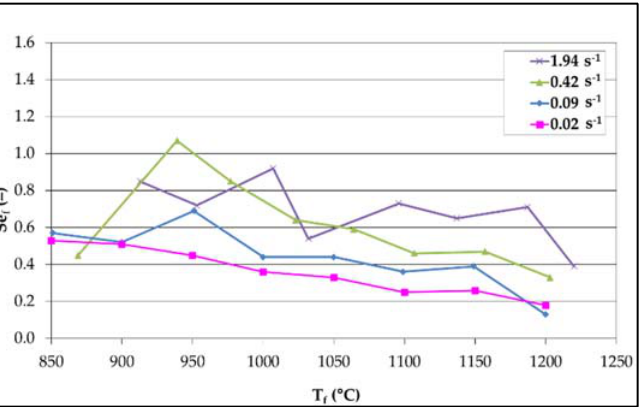
Figure 2. Dependence of the fracture strain intensity ( Se f ) on the test temperature ( T f ), and strain rate, 0.08 wt. % Bi.